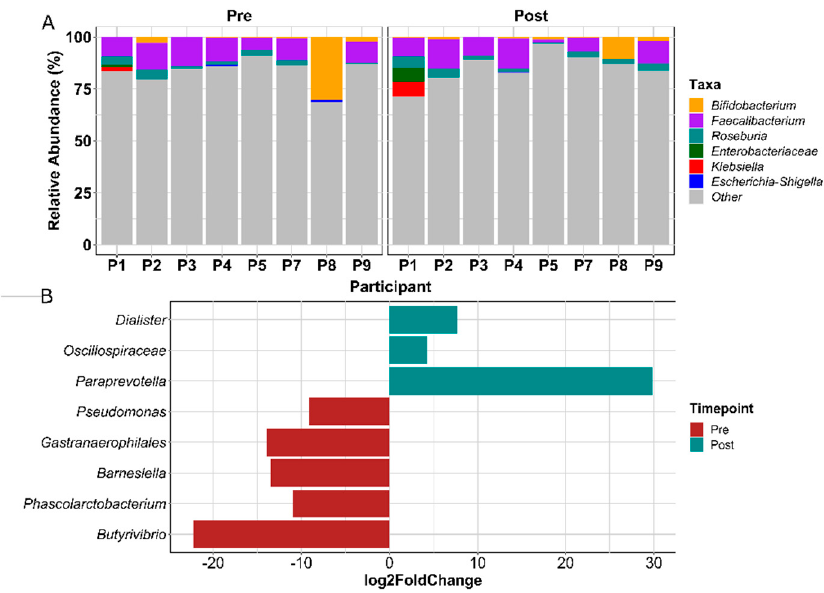
Figure 5. Gut microbiota differential abundance analyses from 16S rRNA sequencing. Relative abundance of three health-associated and three inflammation-associated microbiota were analyzed using DESeq2, showing no significant differences ( A ). Eight microbiota were significantly differentially abundant between pre- (baseline) and post- ACE (12 weeks) samples when analyzed with DESeq2 ( p < 0.01) ( B ).